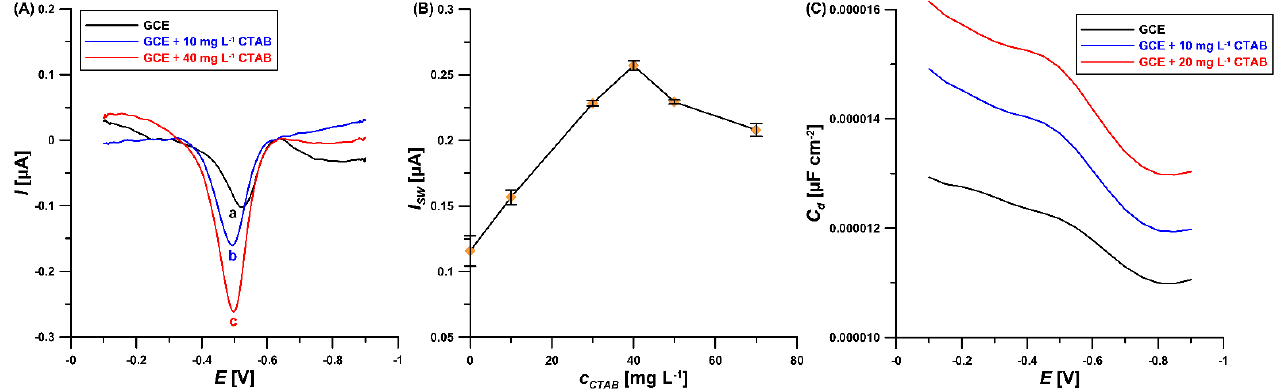
Figure 1. (A ) SWV curves of 5 µM ROX in 0.05 M NaAc – HAc buffer (pH = 5.6) recorded without (a), and in the presence of 10 mg/L (b) and 40 mg/L CTAB (c). ( B ) The relationship between CTAB concentration and 5 µM ROX peak current intensity. ( C ) The differential capacity-potential curves of the double-layer interface GCE/ NaAc – HAc buffer (pH = 5.6) in the presence of 0, 10 mg/L and 20 mg/L CTAB (frequency of 200 Hz). The solution was stirred for 60 s before each measurement. The standard deviation was calculated for n = 3.